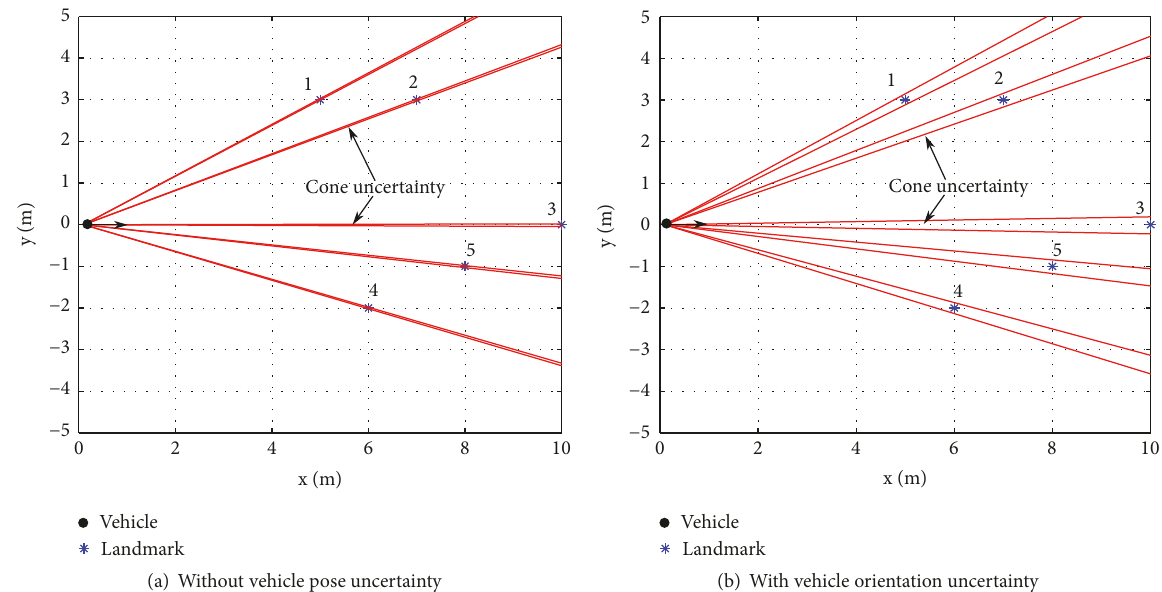
Figure 5: Interval based landmark initialization.